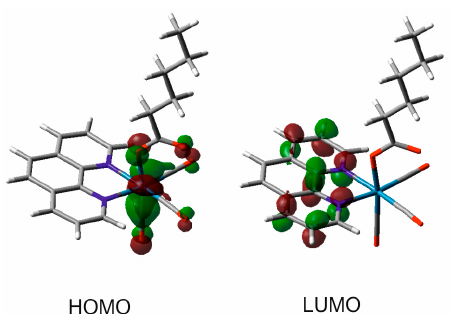
Figure 4. Frontier orbitals of 1 resulting from density-functional (DFT) calculations.